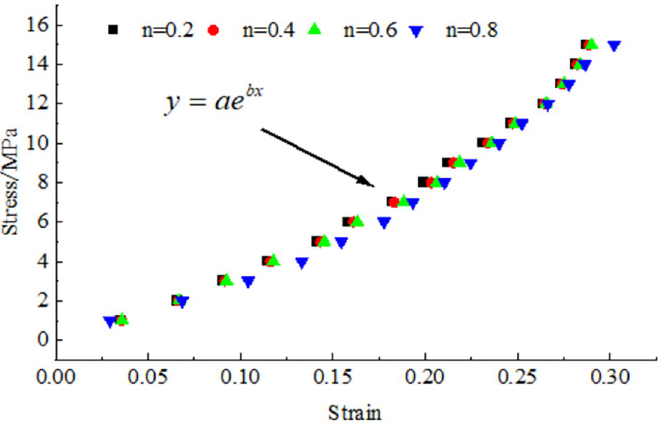
Fig 5. Stress-strain relationship of crushed coal rock mass with different grading structure.